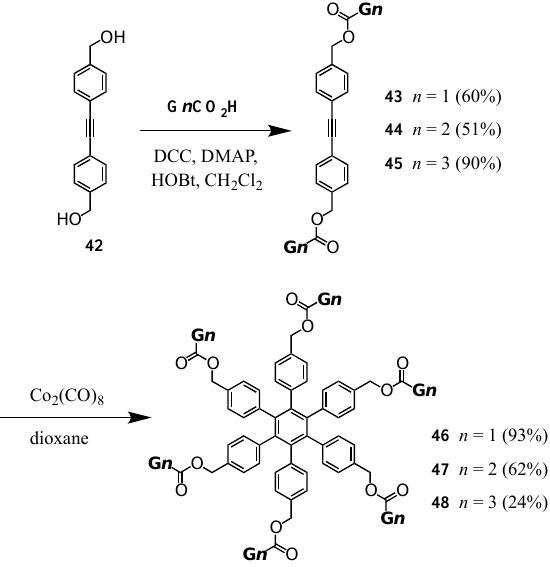
Scheme VIII. Schematic synthesis of fullerene-rich cyclotrimers 46 - 48